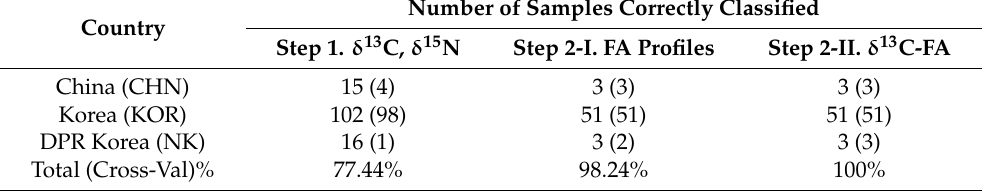
Table 7. Number of individual clams with geographical origins determined using LDA with a stepwise approach. The numbers indicate the samples whose origin was well identified among the samples from each country (China, n = 3; DPR Korea, n = 3; Korea, n = 51). All data are cross-validation results for each geographical origin using the leave-one-out cross-validation (LOOCV) method. Number of Samples Correctly Classified Country Step 1. δ 13 C, δ 15 N Step 2-I. FA Profiles Step 2-II. δ 13 C-FA China (CHN) 15 (4) 3 (3) Korea (KOR) 102 (98) 51 (51) 51 (51) 3 (3) Total (Cross-Val)% 77.44% 98.24%